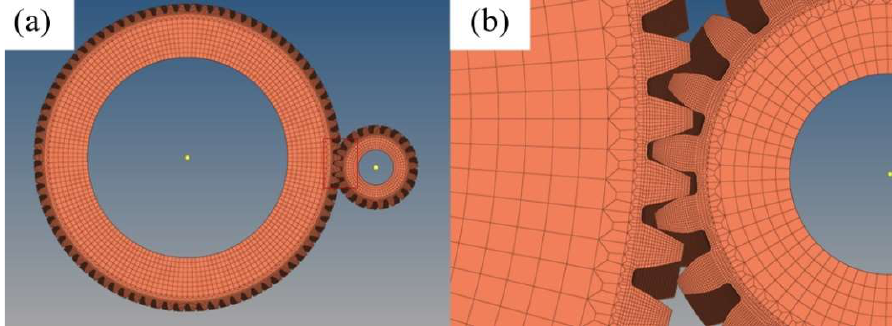
Figure 1. ( a ) Model after meshing ( b ) mesh elements at the meshing of the gear teeth. The model was analyzed by FEM, and the parameters of the solver are set as shown in Table 6. Table 6. Solver parameter